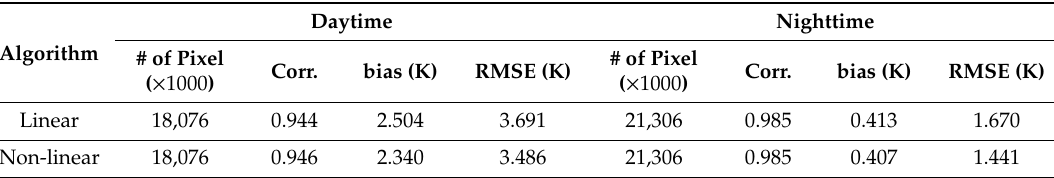
Table 6. Comparison results of the GK2A LST data and the MODIS LST product (Collection 6) using a linear algorithm and non-linear algorithm according to the daytime and nighttime in September 2019.